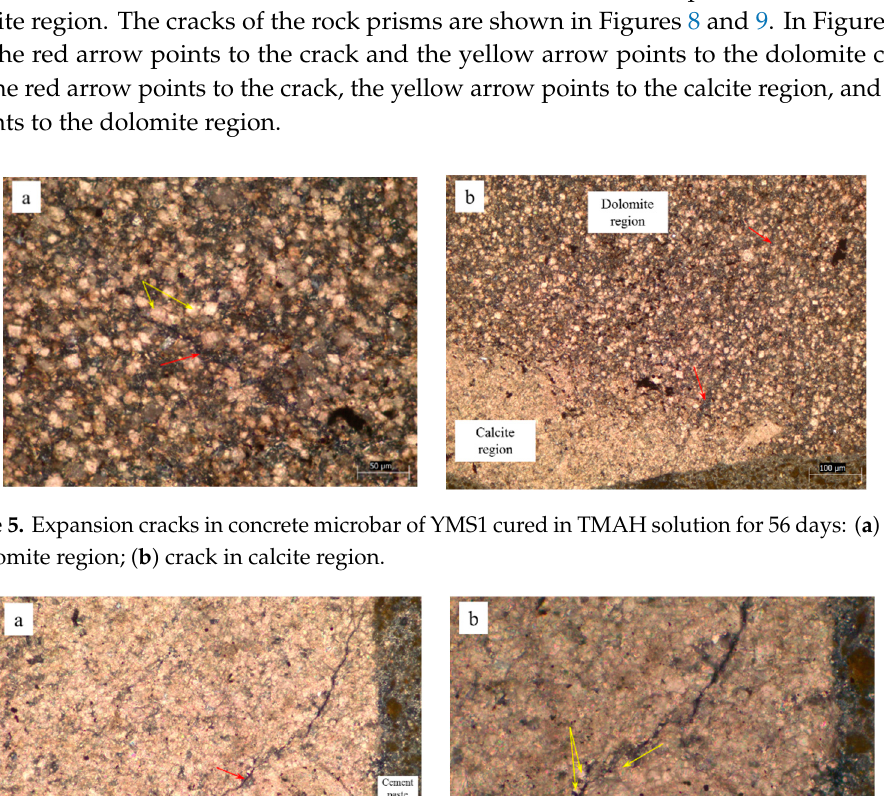
Figure 4. Expansion rate curve of specimens cured in tetramethylammonium hydroxide (TMAH) solution: ( a ) concrete microbars, ( b ) rock prisms.